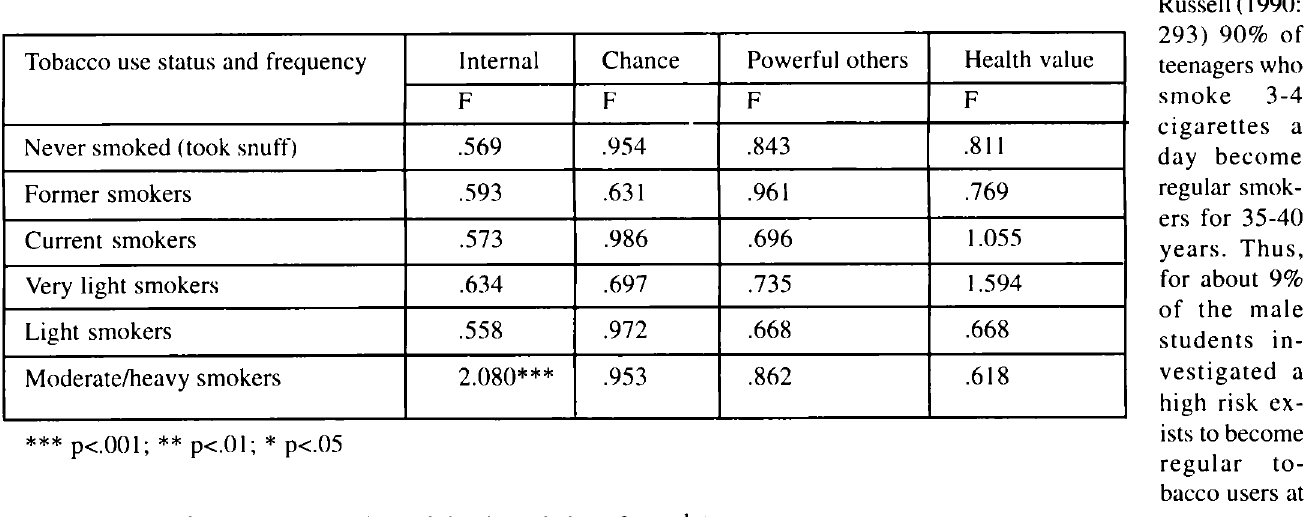
Table 4: ANOVA between tobacco use, Health Locus of Control and Value for